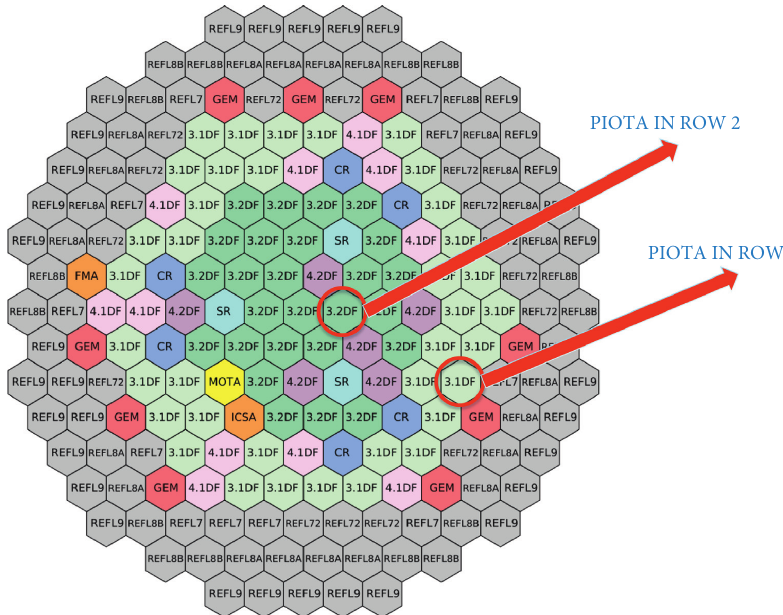
Figure 2: Core loading for LOFWOS test